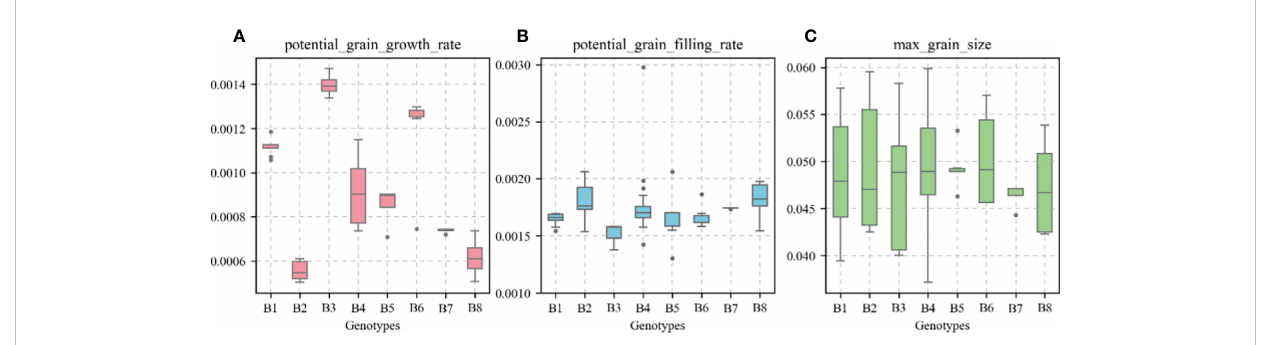
FIGURE 15 Values of variety parameters in the APSIM-Wheat model for different genotypes. (A) , potential grain growth rate; (B) , potential grain fi lling rate; (C) , max grain size.